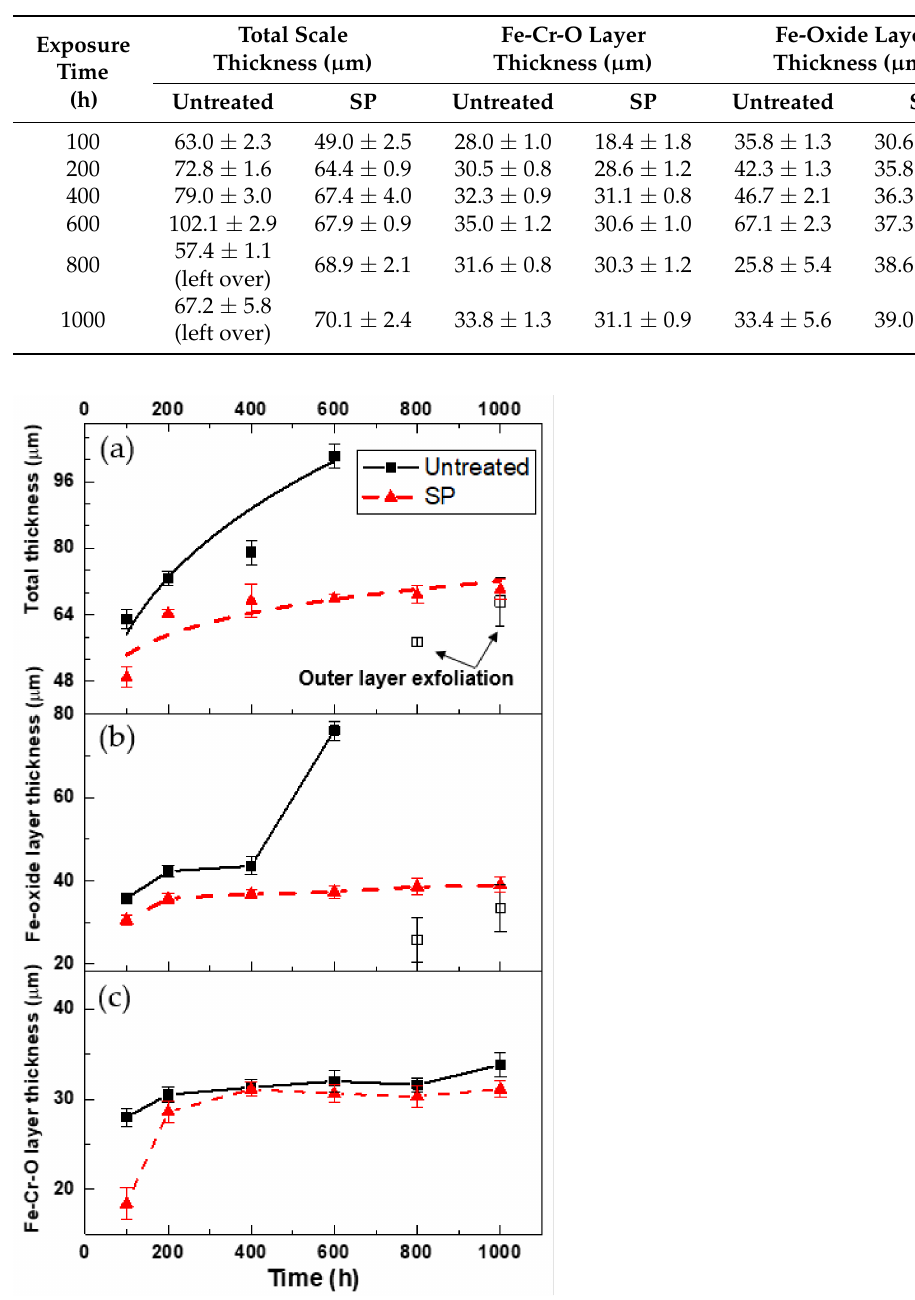
Table 3. Oxidation scale layer thickness of untreated and shot peened T91 specimens after steam